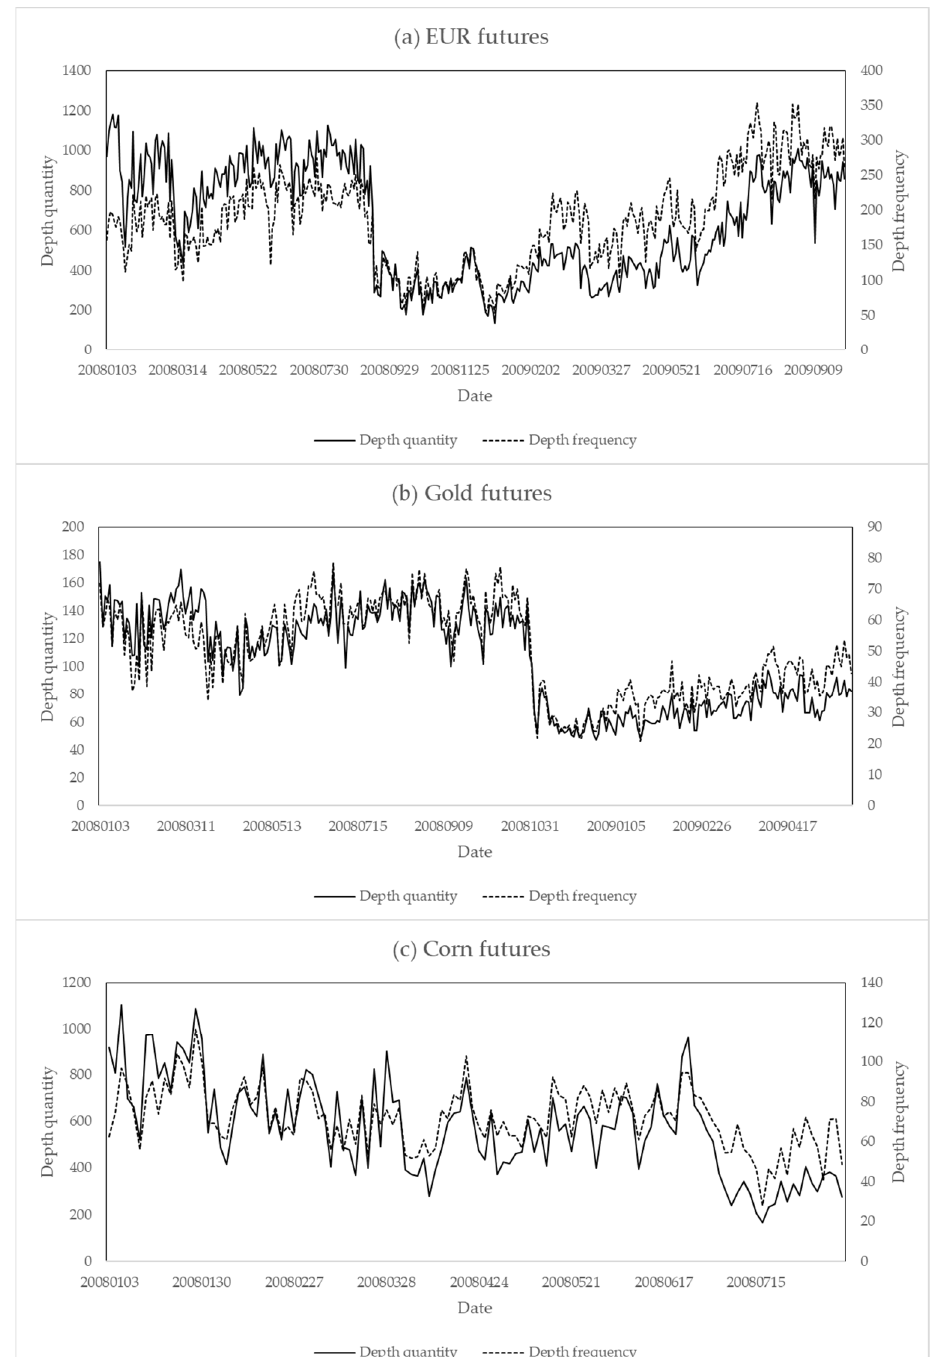
Figure 2. Daily depth. This figure presents the daily depth for each futures contract. ( a ) depicts EUR futures, ( b ) depicts Gold futures, and ( c ) depicts Corn futures. Intraday depth measures are averaged over the day using fifteen-minute time interval data. Depth quantity is calculated as the sum of the depth available across all five levels in the limit order book. Depth frequency is calculated as the sum of the number of orders available across all five levels in the limit order book. Table 6. Depth quantity and structural breaks. This table presents the coefficient estimates for the follow- ing model: is one of three measures of volatility. GK volatility is the Garman and Klass (1980) measure of volatility that consists of the high, low, open, and close price values within an interval. Returns volatility is defined as the